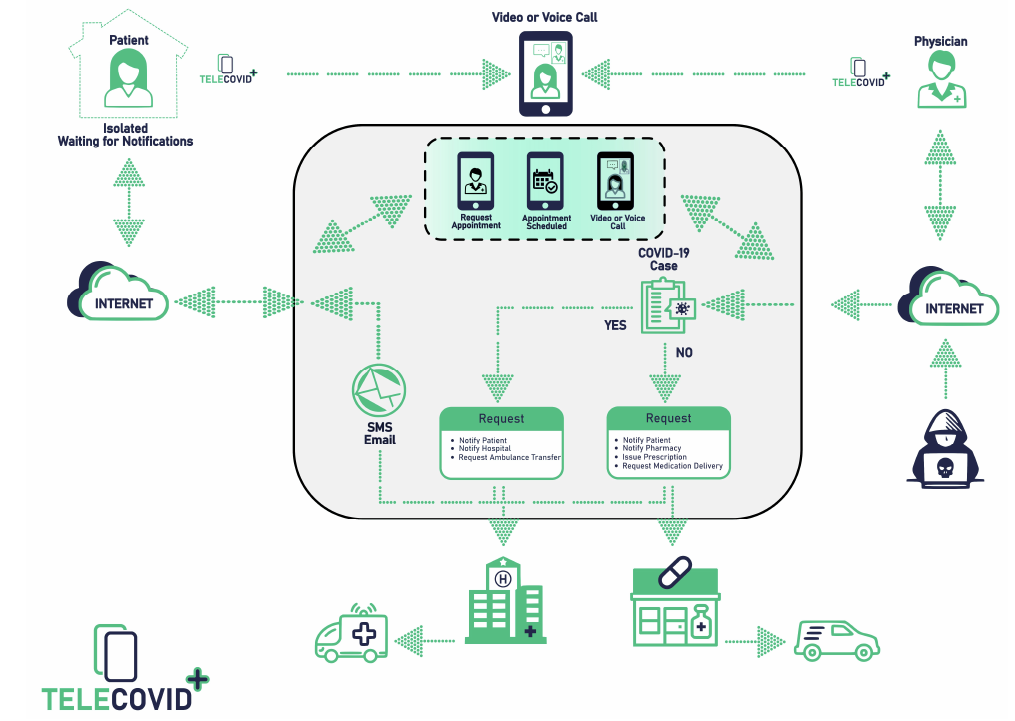
Figure 1. Basic structure of Tele-COVID using SOA